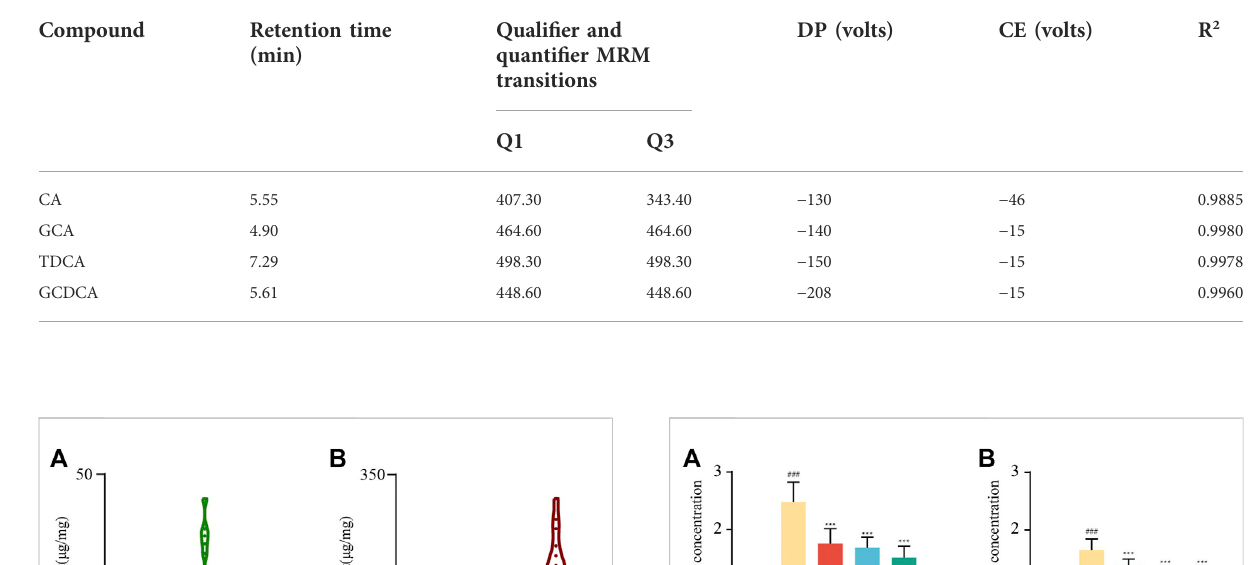
TABLE 1 Mass spectrum information of key feature markers by UPLC-QQQ-MS.